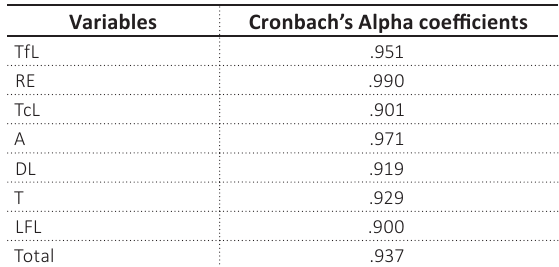
Table 3. Questionnaire reliability